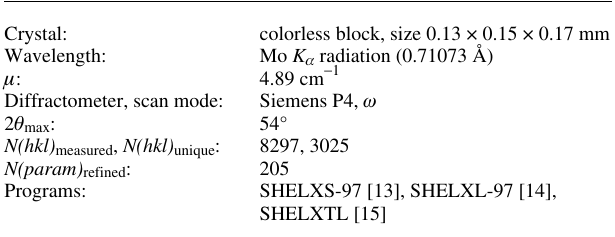
Table 1. Data collection and handling.